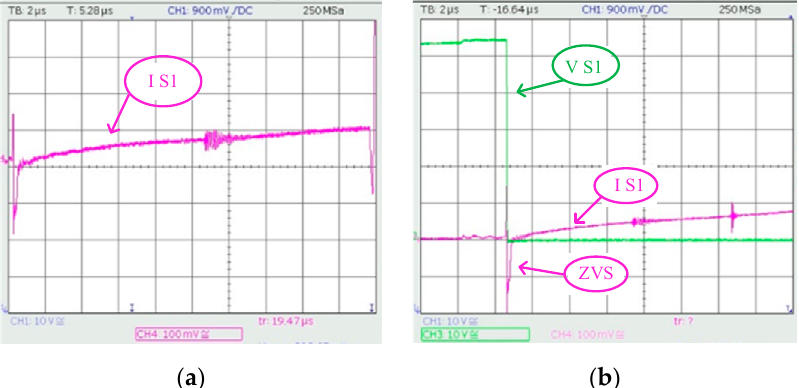
Figure 14. ( a ) Current waveform of Switch 1. ( b ) Current and voltage waveforms of Switch 1.